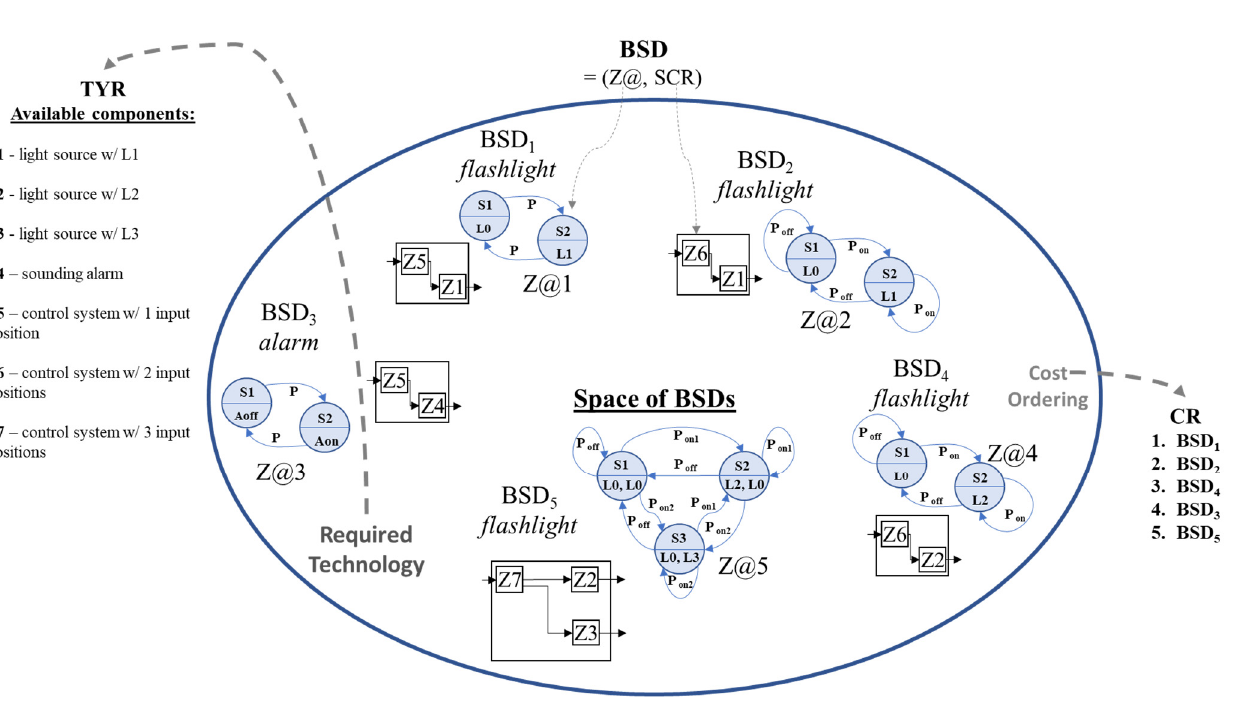
Figure 9. Practical illustration of the Buildability perspective to showcase the process for engineering a flashlight; including system designs that are built from available technology and an ordering according to preferred cost. The diagram does not represent a single model of the system, but a solution space. Each pair state machine/block diagram represents one possible solution inside the buildability space. This figure is used only to support our narrative to explain Wymore’s T3SD. The figure is NOT a formal visualization of any model.